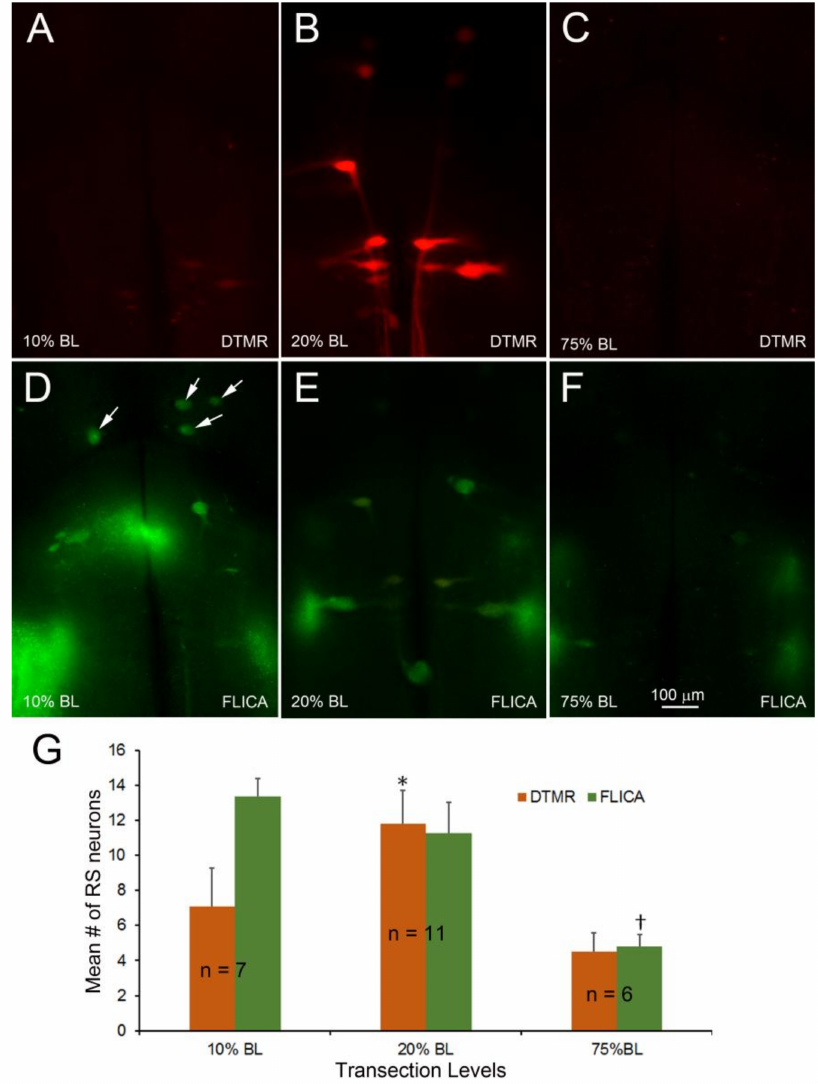
Figure 9. The distance from the perikaryon reduces apoptotic signaling independently of the axon sealing time. TXs were made at 10%, 20%, or 75% BL. DTMR was applied 24 h later to label late-sealing RS neurons. The animals were allowed to survive for 2 weeks, and their brains were processed for FLICA staining. ( A – C ) sealing was least complete when the TX was at the 20% BL, where axon caliber is the largest; ( D – F ) FLICA labeling was the greatest when TX was at the 10% BL—i.e., closest to the perikaryon—significantly greater than when TX was at 75% BL, even though axon resealing was not significantly different ( G ). * p = 0.018 for the difference in the number of DTMR-labeled neurons between 20% BL and 75% BL, † p = 0.018 for the difference in the number of FLICA-labeled neurons between 20% BL and 75% BL, and p = 0.0001 between 10% BL and 75%